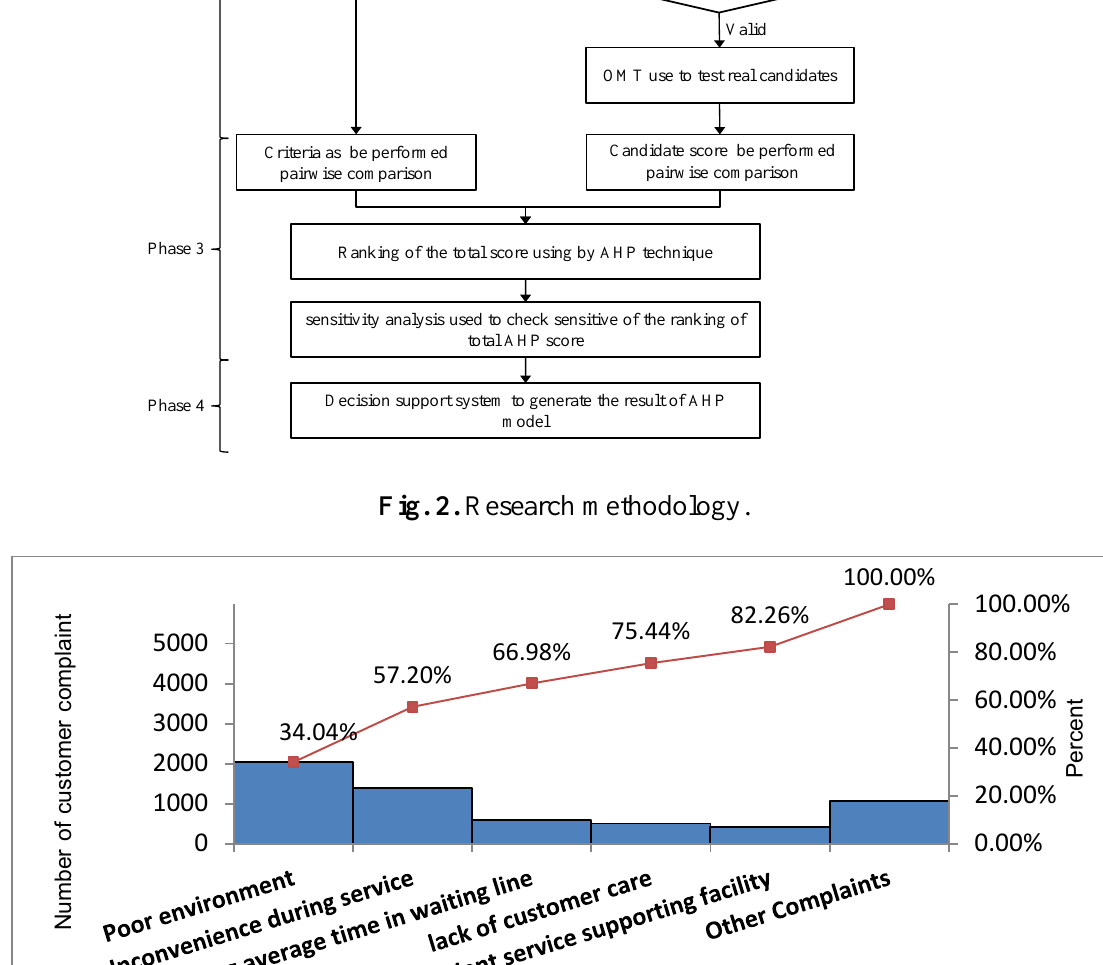
Fig. 3. Pareto chart of customer complaint at service